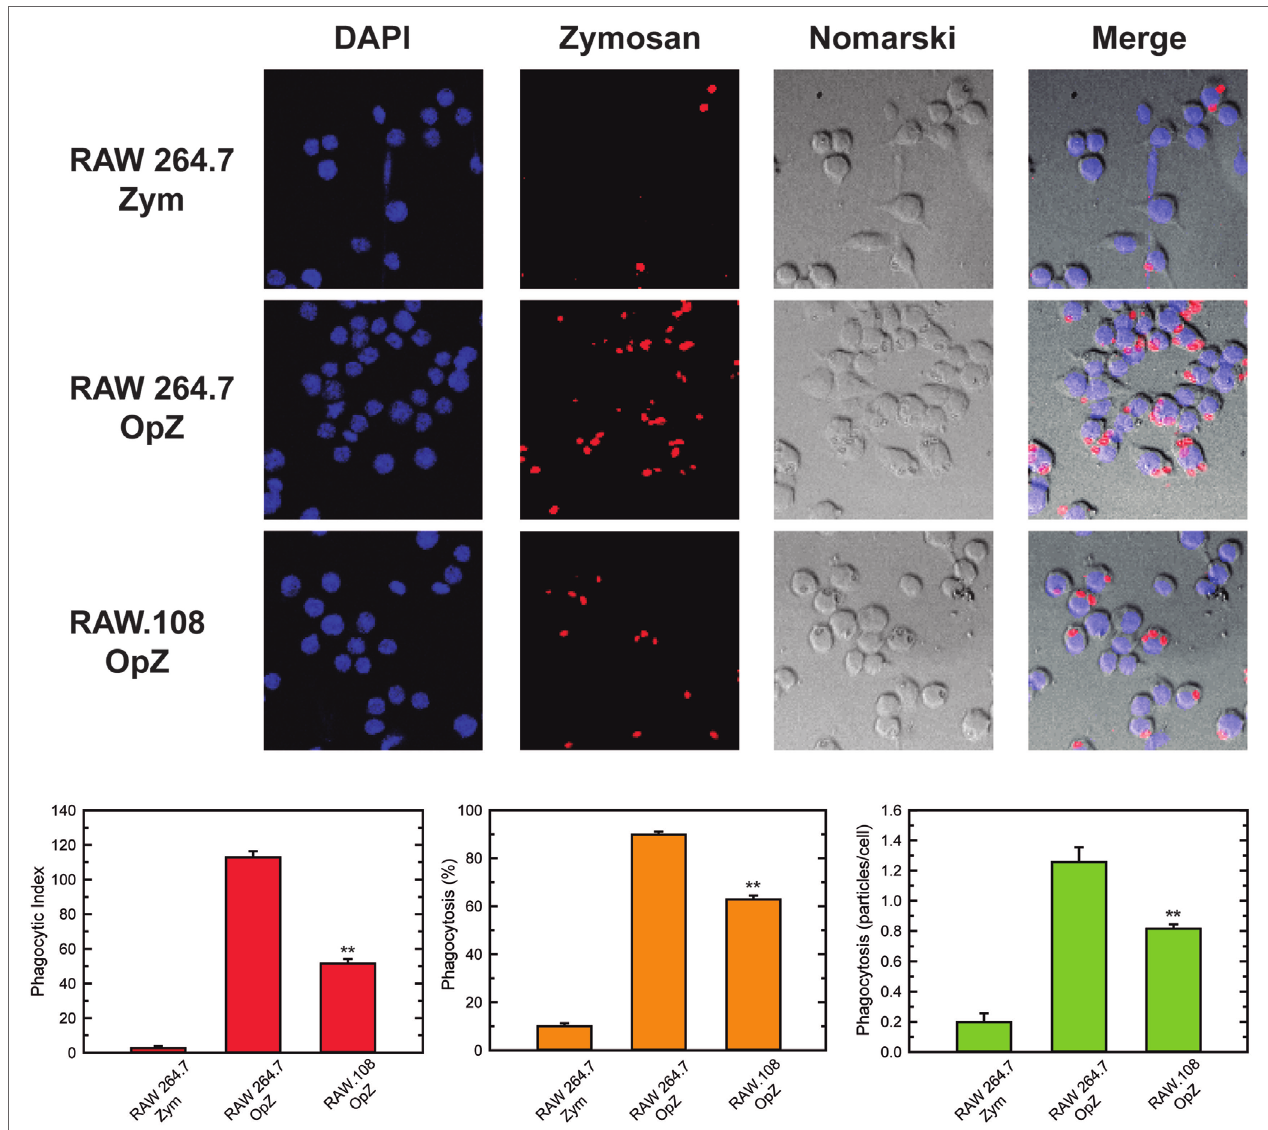
FigUre 1 | Phagocytosis of zymosan particles in RAW 264.7 and plasmalogen-deficient RAW.108 cells. The cells were exposed to fluorescent non-opsonized (Zym) or opsonized zymosan (OpZ) particles for 30 min, as indicated (10 particles per cell, equivalent to approximately 0.2 mg per million cells), and analyzed for phagocytosis of fluorescent zymosan particles by confocal microscopy (red color, middle columns). DAPI (1 µg/ml) was used to mark the nuclei (blue, left columns). Nomarski and merge images are also shown (right columns). The average of three independent experiments with 20 determinations each is shown (mean ± SEM) (bottom panel). Original magnification, × 20. **Significantly different ( p < 0.01) from RAW 264.7 cells exposed to